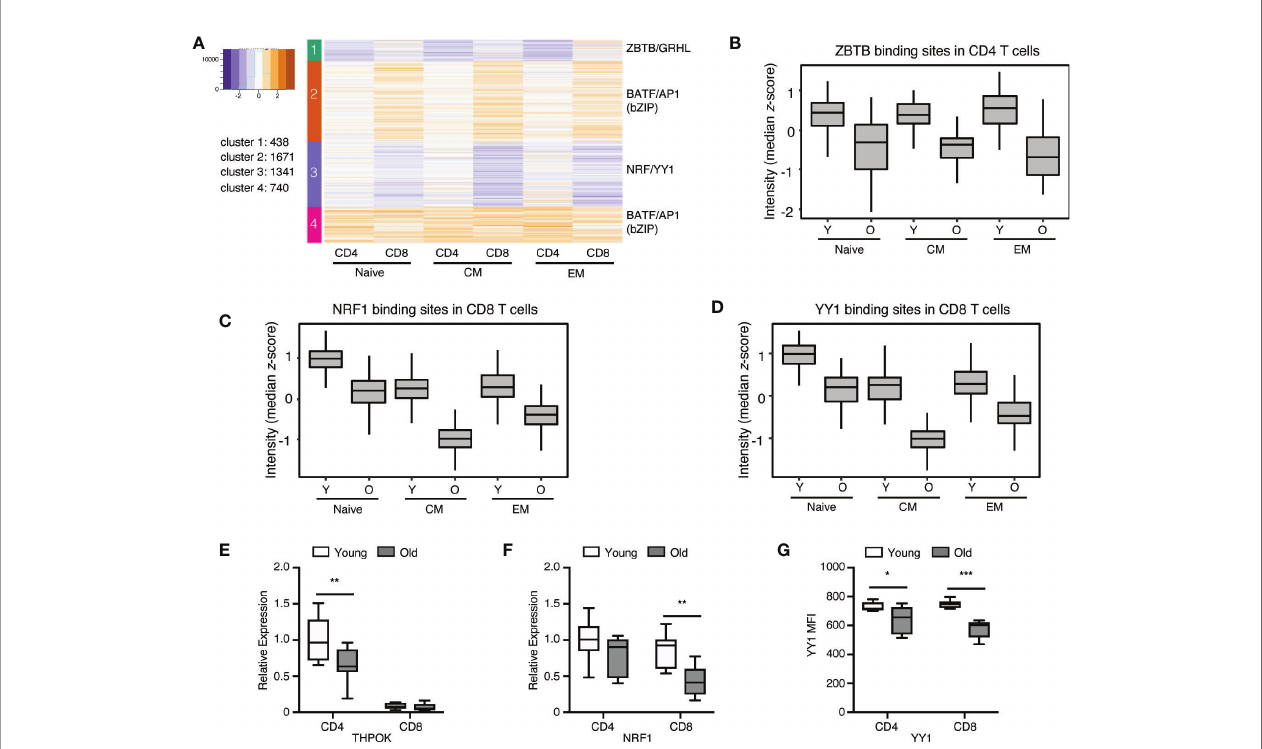
FIGURE 5 | CD4 and CD8 subset-speci fi c changes in chromatin accessibility with age. (A) Age-associated differences in chromatin accessibility for CD4 and CD8 T cells were expressed as log2 fold differences and were clustered using k -means statistics. Log2 fold differences of accessibility for sites within each cluster are shown as heat plots organized in columns of CD4 and CD8 T cell subsets. Top transcription factor motifs enriched at sites in each cluster, as determined by HOMER, are shown at the right margin. (B – D) Box plots show motif intensities for selected TFs, (B) ZBTB in CD4 T cells, (C) NRF1 and (D) YY1 in CD8 T cells, as identi fi ed in (A) . The motif intensity was calculated based on the z -score of the median accessibility for each group. (E, F) Gene expression of selected TFs THPOK (E) and NRF1 (F) in CD4 and CD8 naïve T cells were determined by qPCR. Results are shown normalized to b -actin expression and relative to the mean expression in young CD4 naïve cells. Box plots show data from 8 young and 8 old adults; statistical analysis by two-tailed t-test. **p < 0.01. (G) YY1 expression was determined by fl ow cytometry of naïve (CD45RA+CD62L+) CD4 and CD8 T cells from 8 young and 8 old donors. Comparisons were analyzed by two-tailed t-test, *p < 0.05, **p < 0.01, ***p <